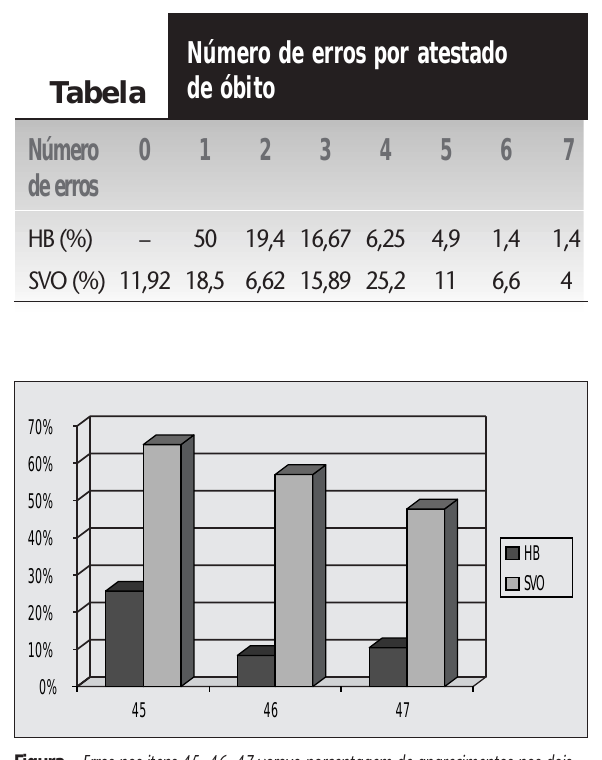
Figura – Erros nos itens 45, 46, 47 versus porcentagem de aparecimentos nos dois